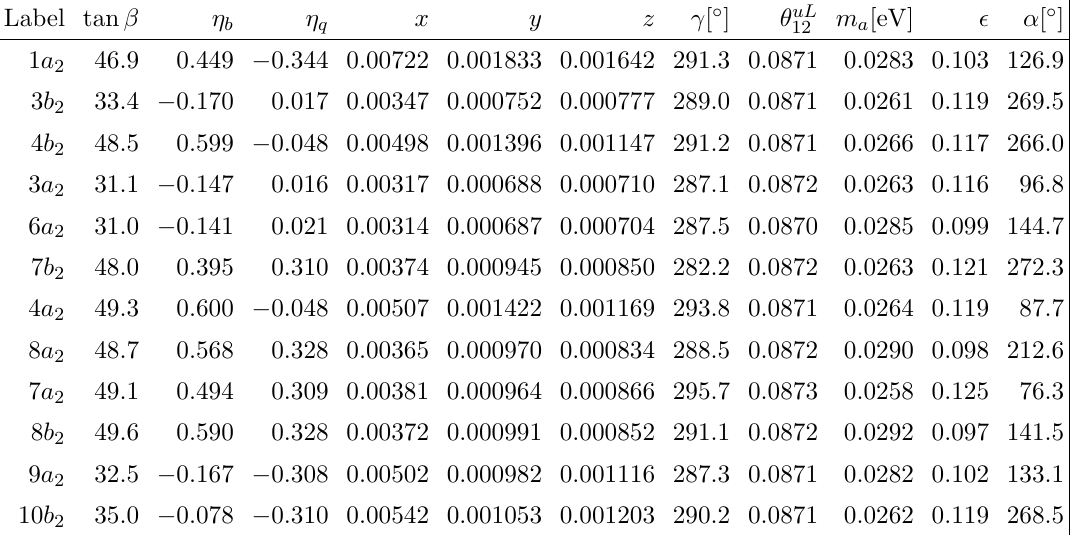
Table 3 . List of best-(cid:12)t models. The table shows the model parameters of the 12 best (cid:12)t points with lowest (cid:31) 2 from table 2. Note that the models 2 and 5 are not considered. The corresponding local minima are essentially the same as the ones in model 1 and 4 respectively, since the tuple of CG coe(cid:14)cients in model 1 and 2, and in model 4 and 5, di(cid:11)er only by an overall factor.